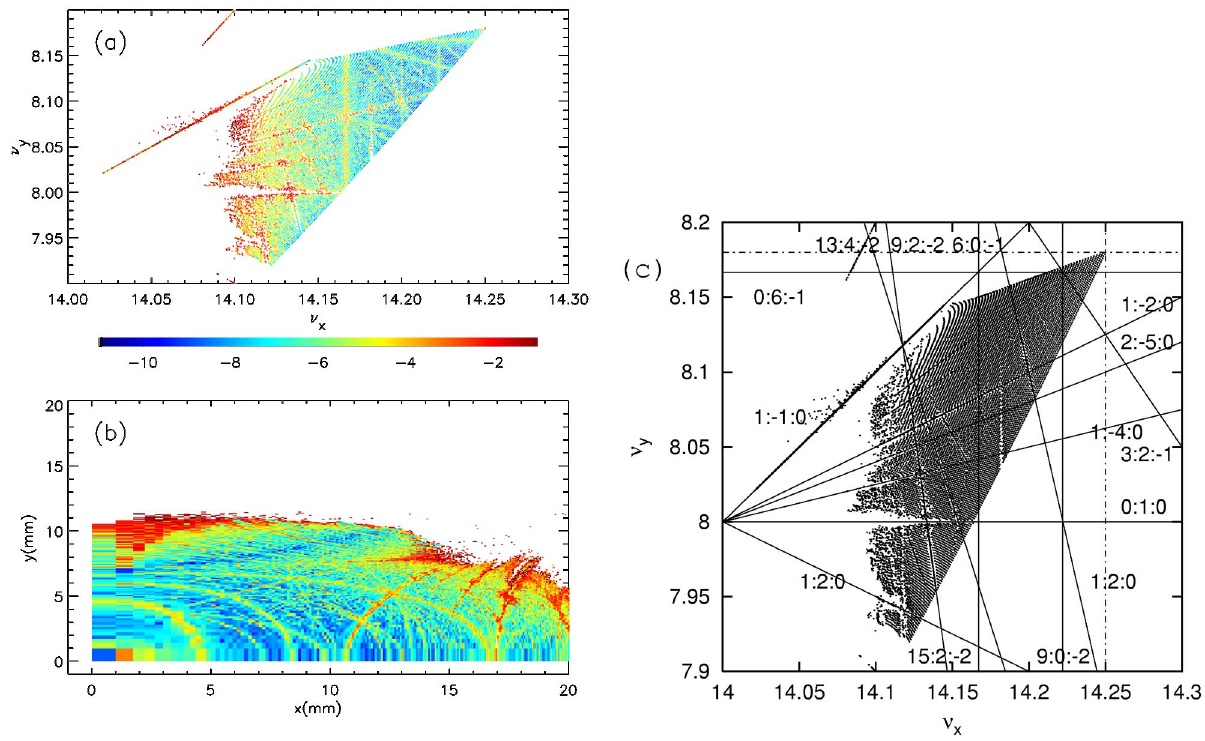
(cid:1) 11 : 3 m and (cid:28) (cid:1) x y